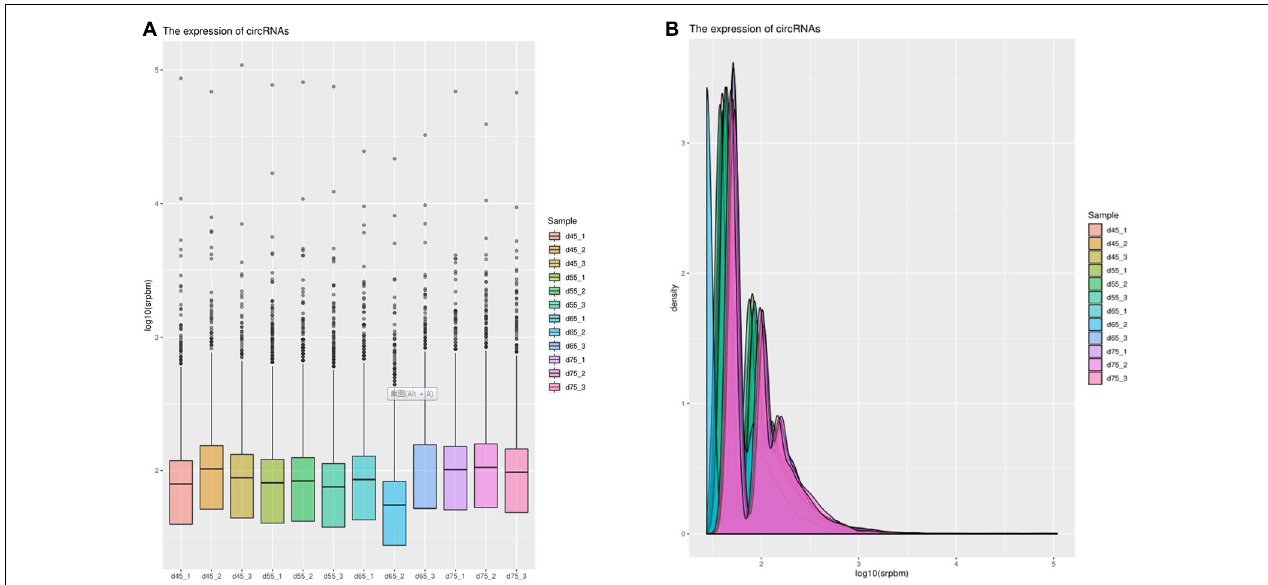
FIGURE 3 | The expression of circRNAs. (A) Box plot showing the expression abundance of circRNAs in each sample. (B) Density plot of the expression density distribution of circRNAs in each sample.